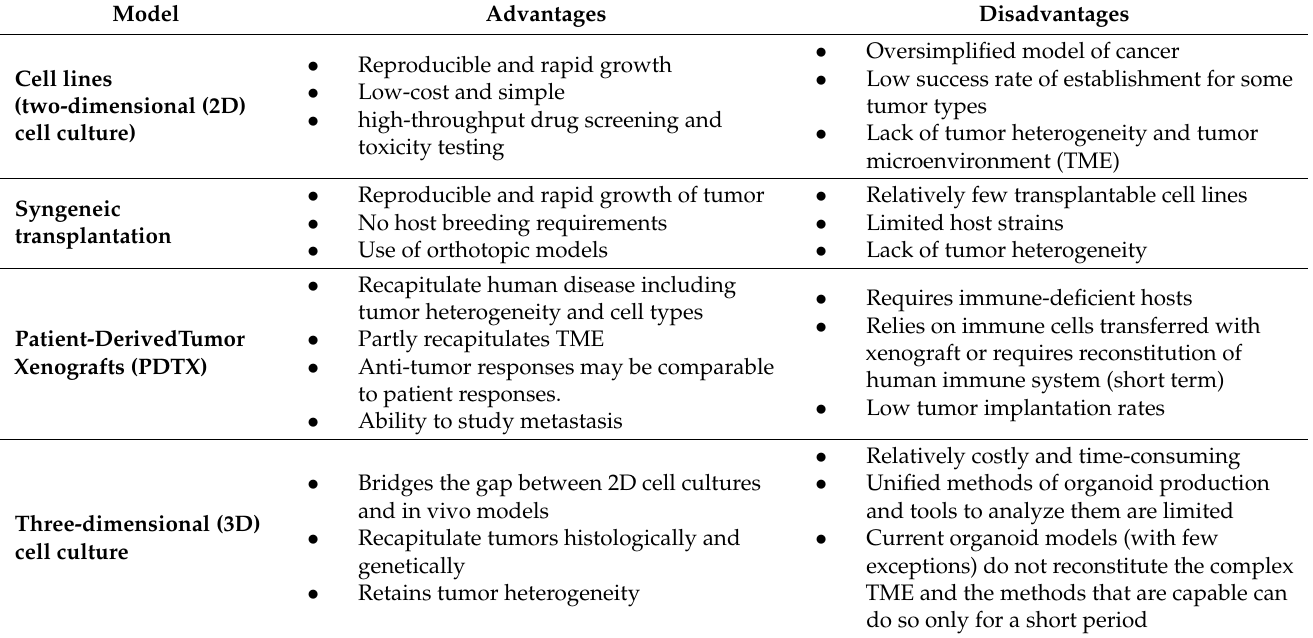
Table 1. Pre-clinical models in cancer